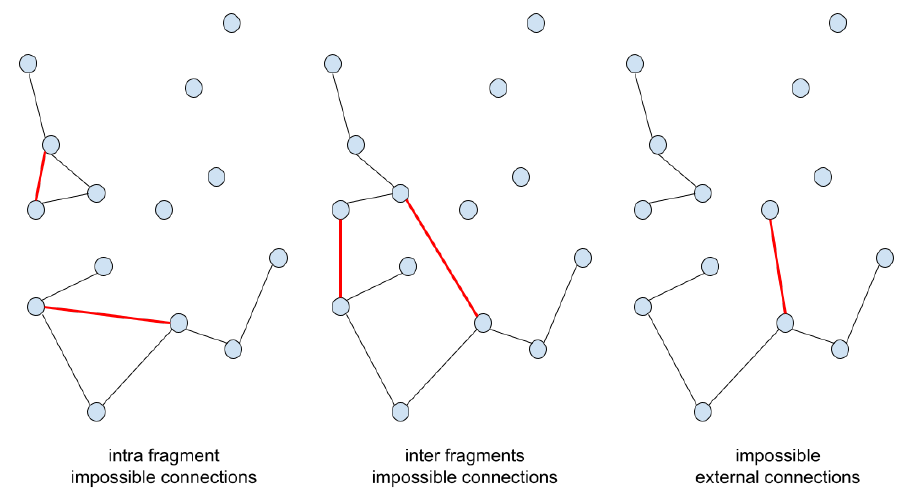
Figure A1. Events that cannot occur as an input to the tracking procedure.